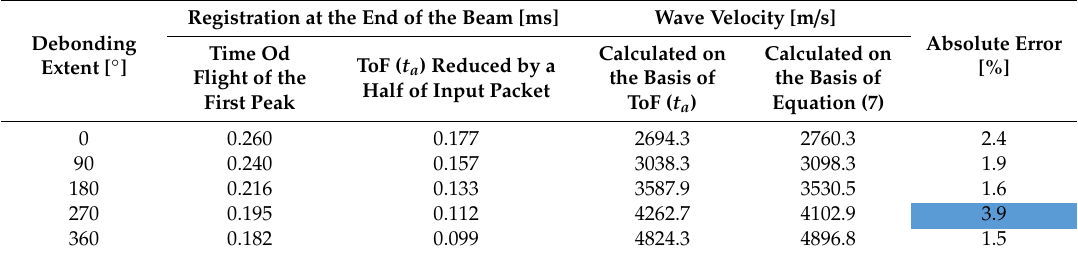
Table 1. Identifying the time of flight on the basis of signals registered at the end of the concrete beam with variable circumferential debonding extent.